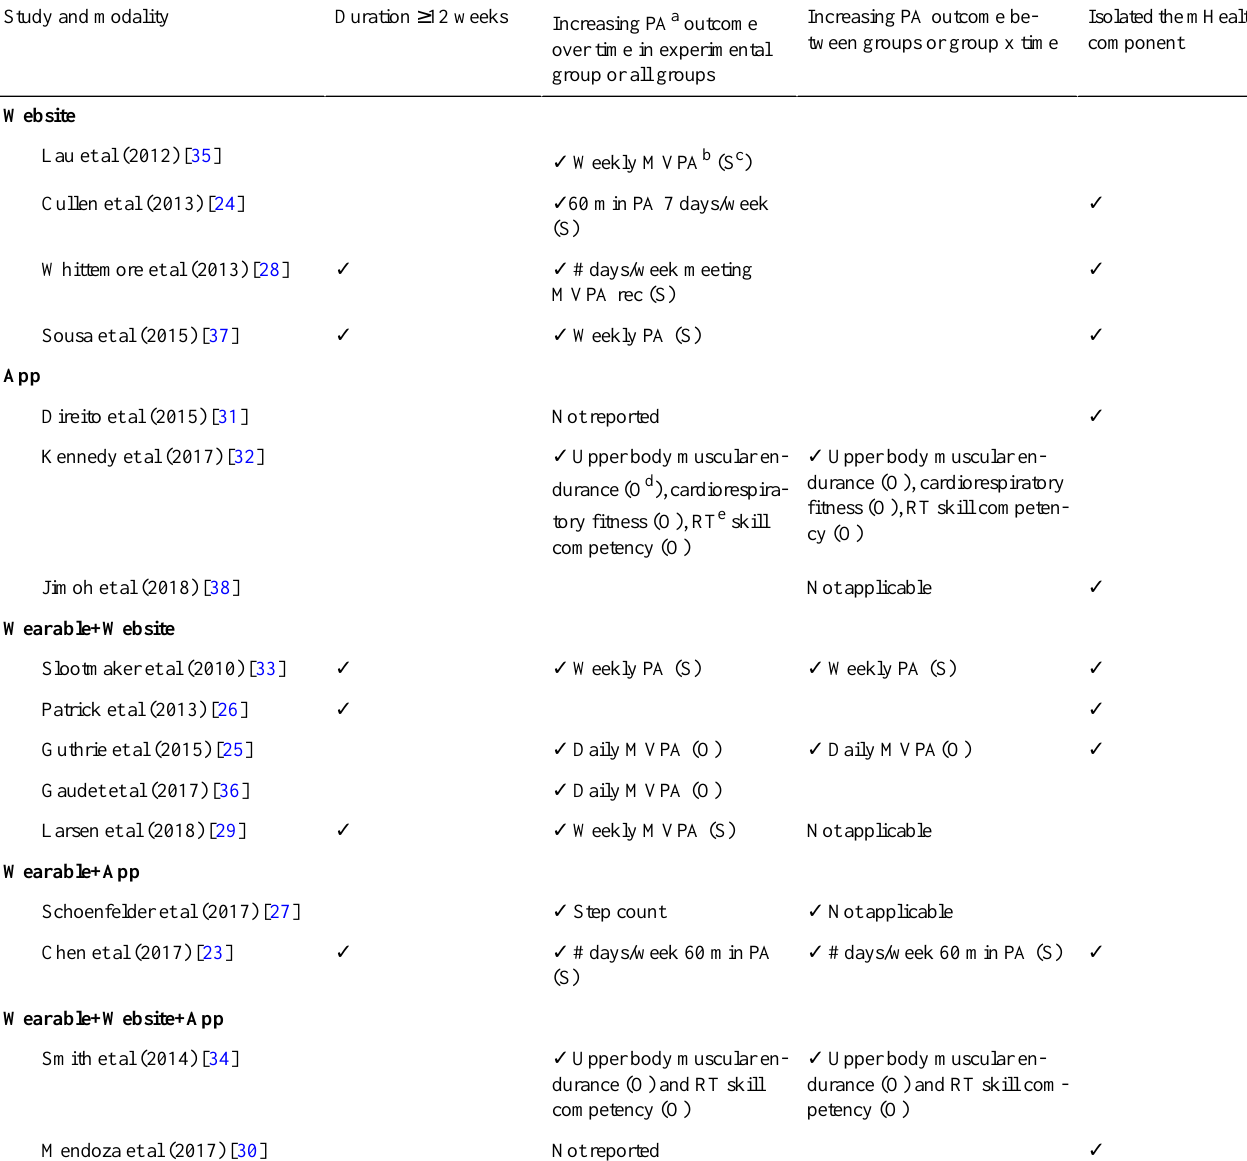
Table 3. Mobile health intervention components and significant improvement in physical activity